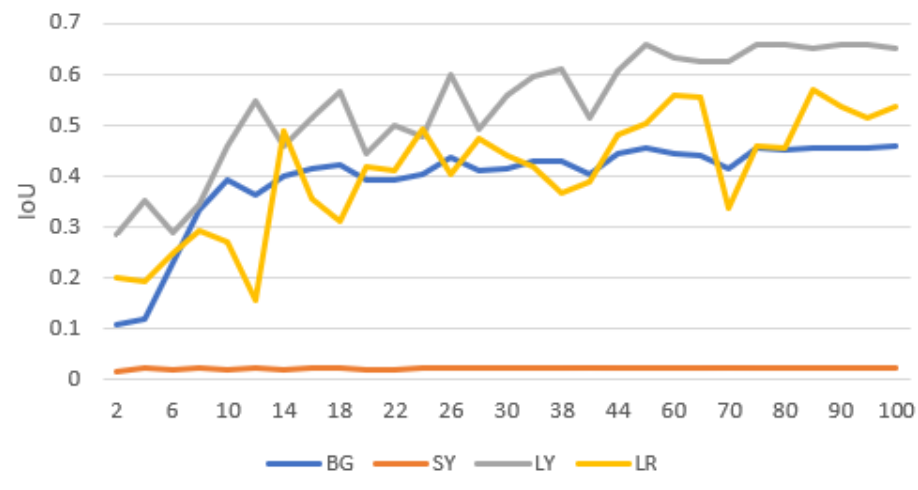
Figure 7. Training graphs of a fully-supervised CCT model with different loss functions. Using CE and ab-CE loss, the model focuses on the largest class and ignores the smallest class. With focal loss, the model is encouraged to also focus on smaller classes.